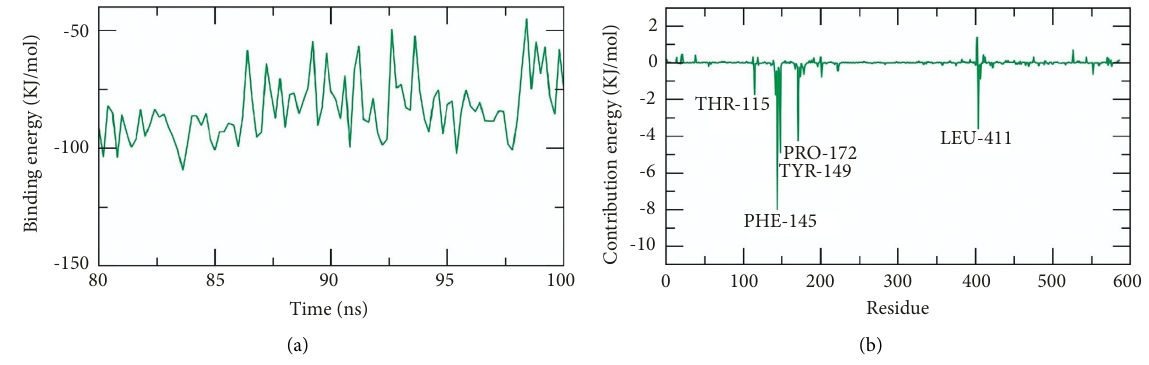
Figure 13: MM-PBSA results of SARS-CoV-2 helicase- 1552